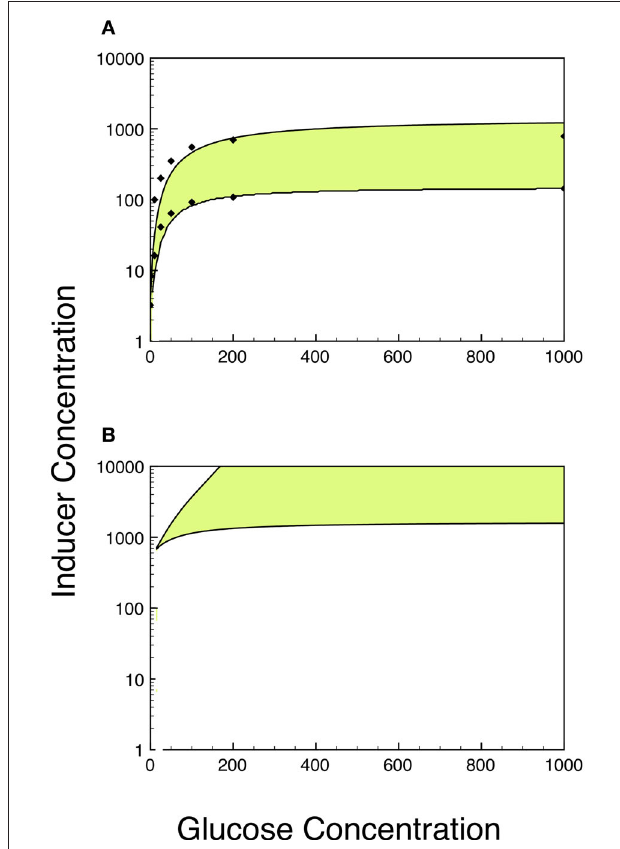
Figure 3 | (A) Bifurcation diagram in the [ T ] vs. [ G ] parameter space, e e calculated for the case when the operon is induced with TMG. The black diamonds correspond to the experimental data of Ozbudak et al. (2004). (B) Bifurcation diagram in the [ L ] vs. [ G ] parameter space, calculated for the case e e when the operon is induced with lactose. In both plots, the shaded region corresponds to bistability, while the monostable induced ( top ) and uninduced ( bottom ) regions are